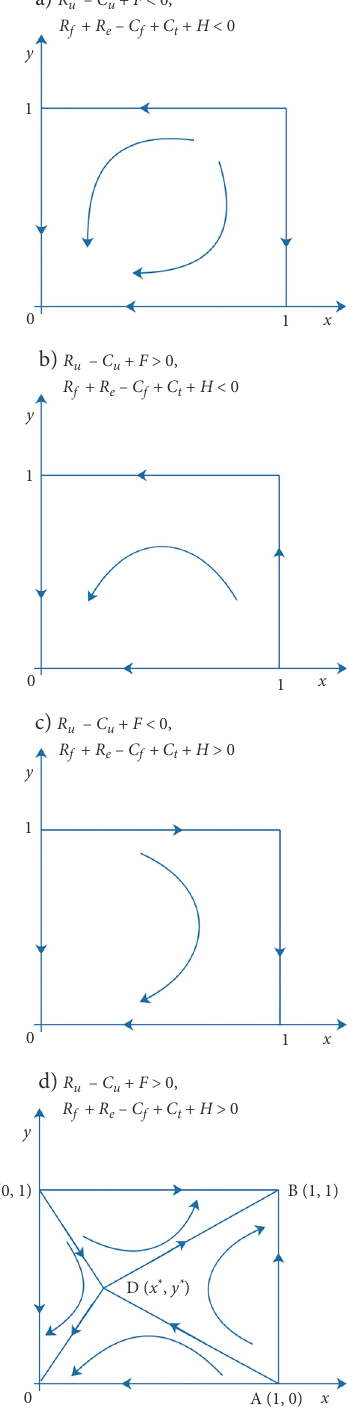
Figure 4. Combination strategy evolution diagram for developers and customers